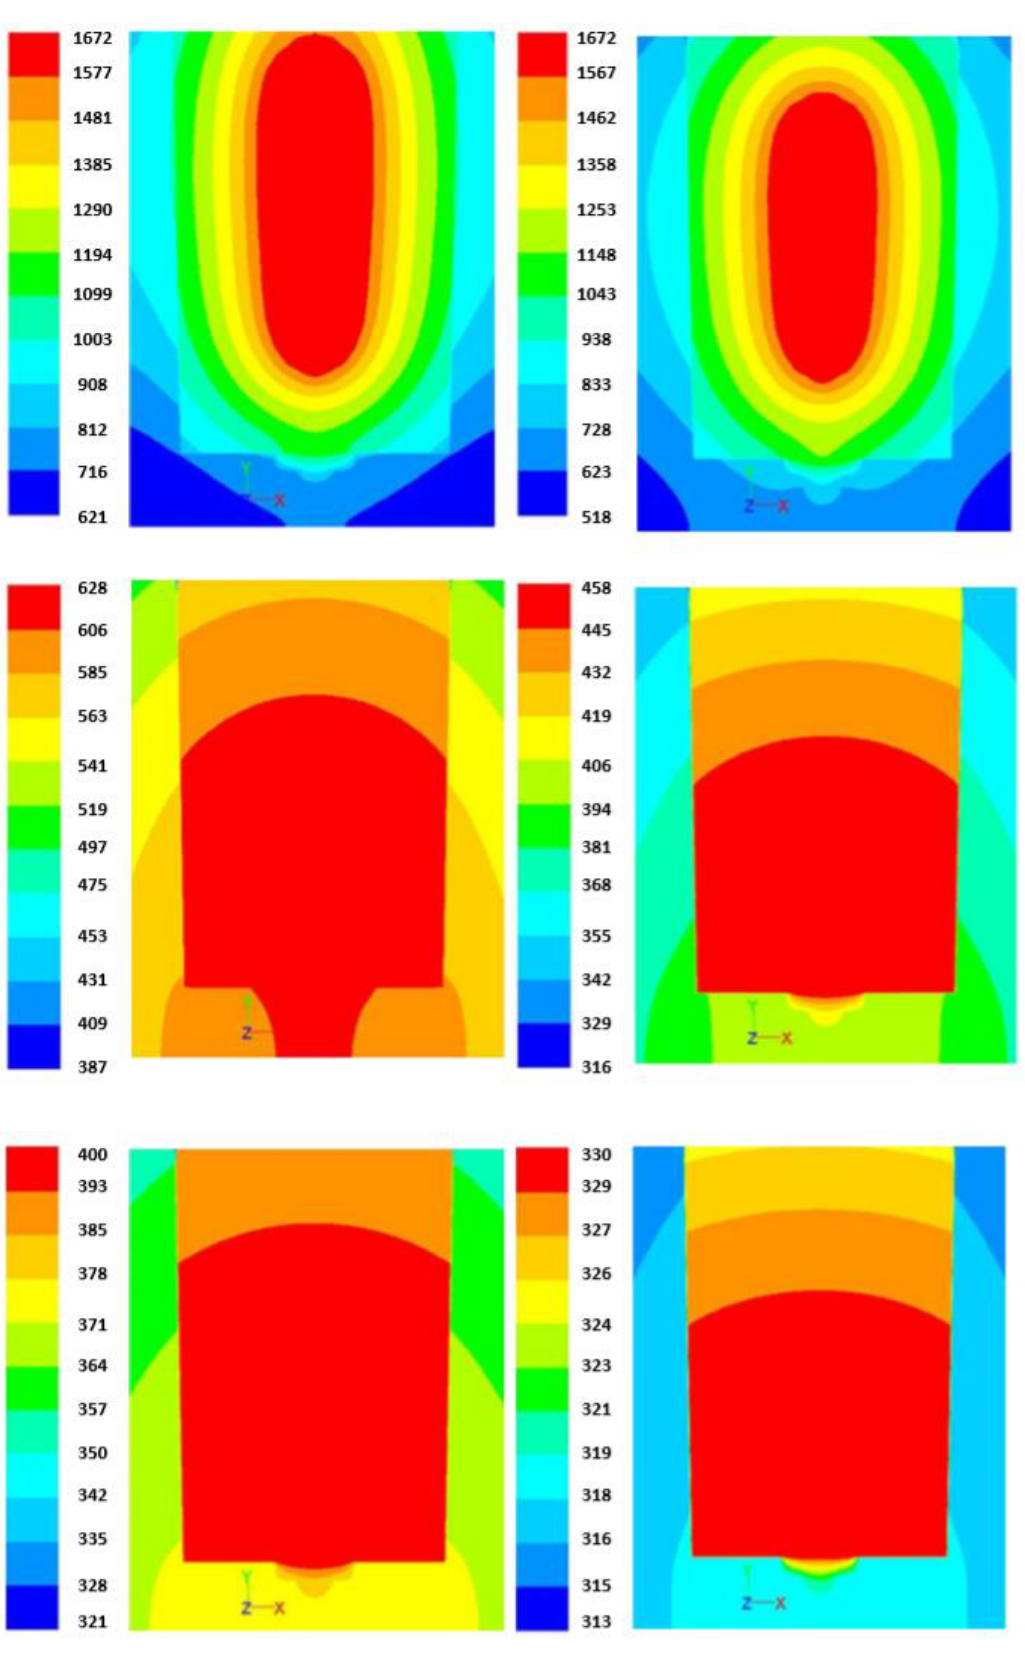
Figure 5. Temperature distribution at transversal plane (drum 1, steel properties). ( Top ) t = 1 h. ( Middle ) t = 10 h. ( Bottom ) t = 24 h. Left : 1 m/s. Right : 3 m/s.